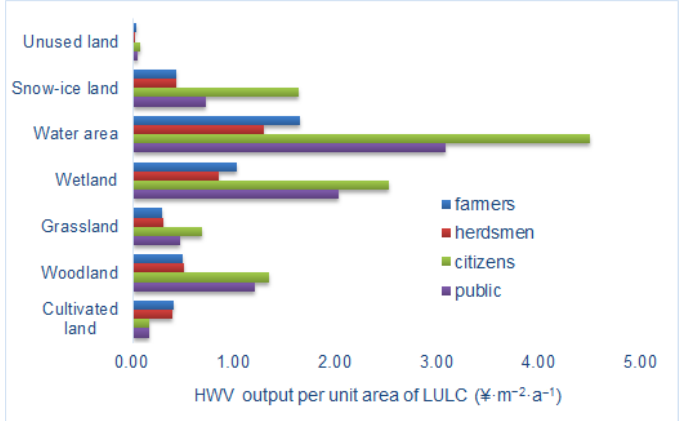
Figure 9. Land use efficiency of LULC for the HWV of stakeholders in the basin.